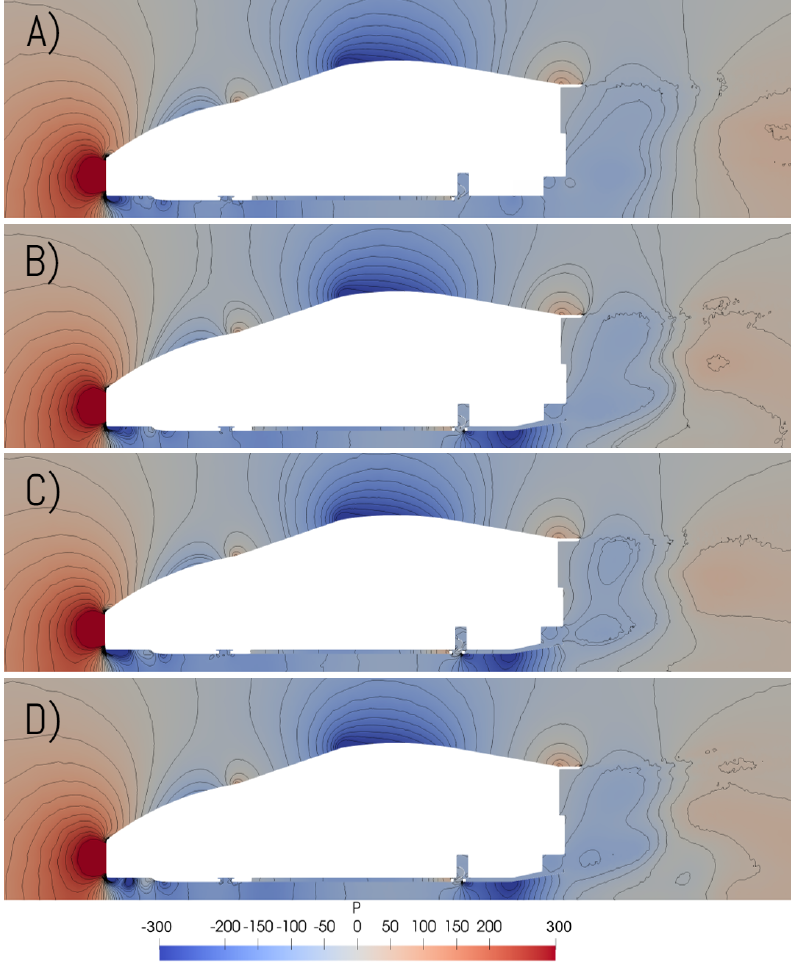
Figure 19. Pressure distribution on the YZ-plane of ( A ) baseline, ( B ) Venturi diffuser, ( C ) Venturi skirts, and ( D ) Venturi frontal configurations. Units are